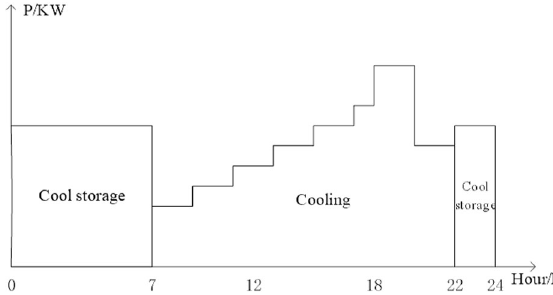
Fig. 2 Full operating mode. The air conditioning system stores enough cold energy in non-air-conditioning period at night to meet the demand of all the air-conditioning load.